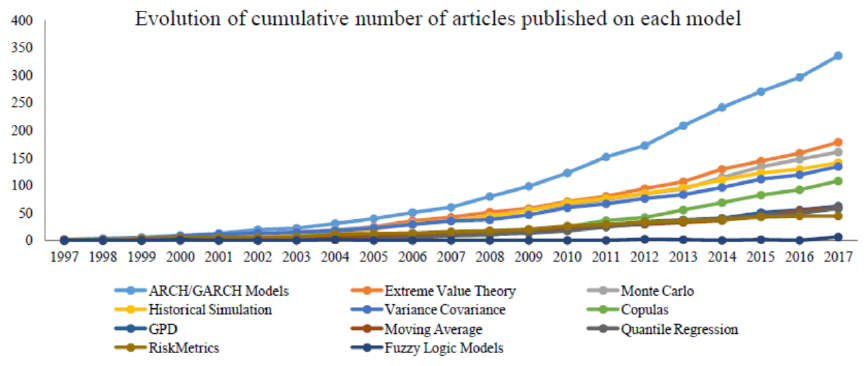
Figure 1. Cumulative number of articles published on models for Value at Figure 1: Cumulative number of articles published on models for Value at Risk